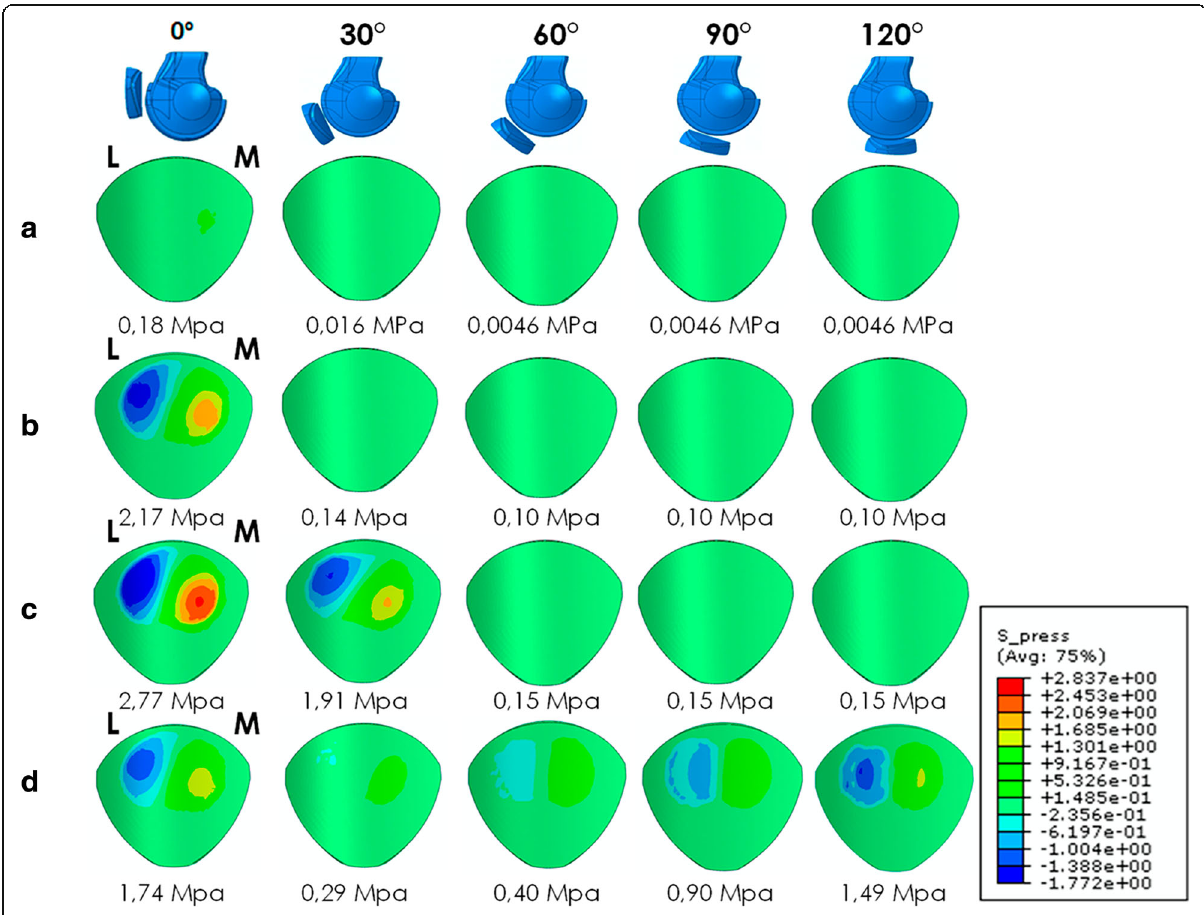
Fig. 3 Patellar cartilage contact pressure (MPa): a Native knee. b Anatomic MPFL reconstruction. c Non-anatomic MPFL reconstruction with